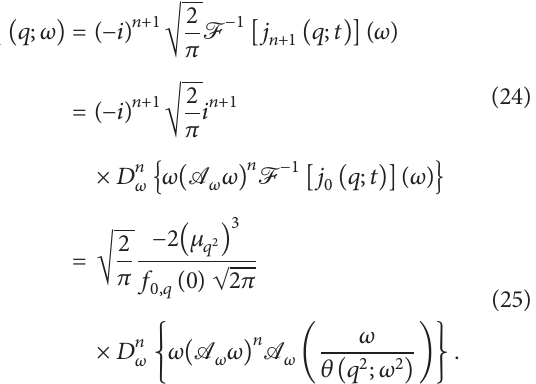
(𝜔)̃𝜒 (𝜔) which is dashed. (c) ̃𝑃 1 [−1,1]